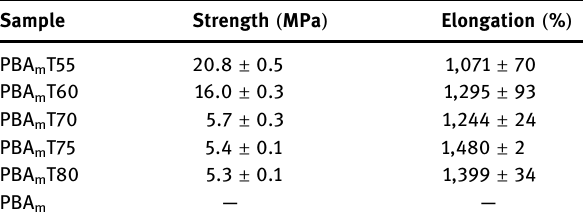
Table 2: Mechanical performance parameters of PBA m T Sample